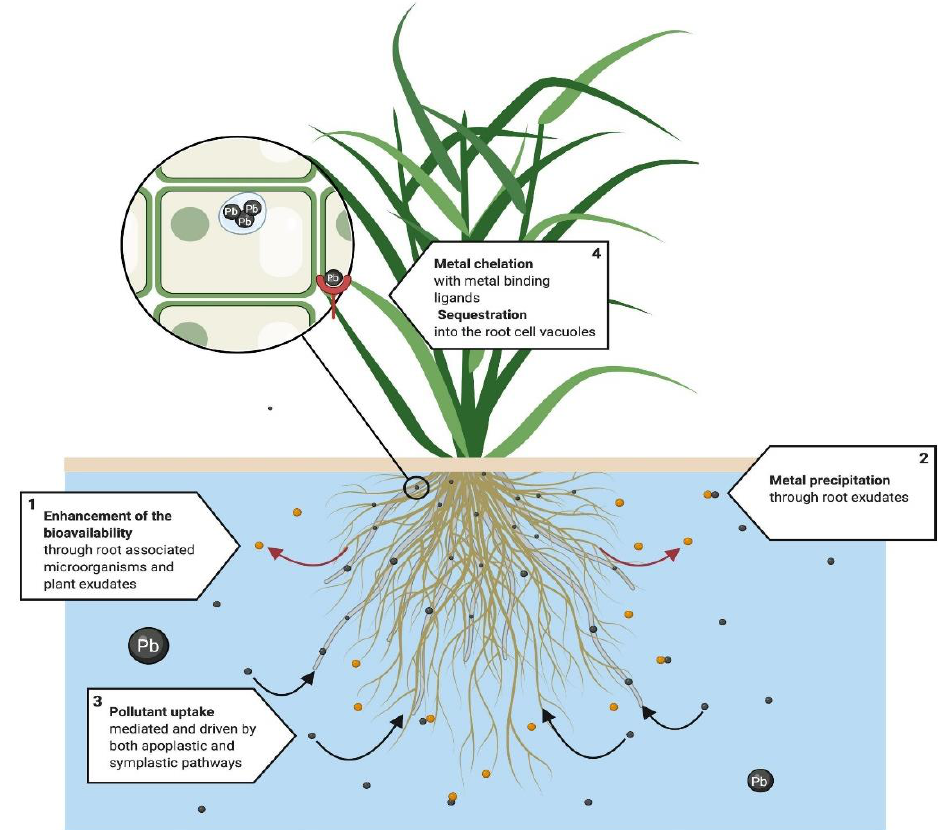
Figure 4. Proposed rhizofiltration system. This technique is mainly used in metal phytoremediation. From a physiological perspective, root exudates and microorganisms (1) enhance bioavailability, followed by (2) the precipitation of metals. (3) Pollutant uptake is mediated and driven by both apoplastic and symplastic pathways. If symplastic pathways fail to translocate the pollutant into leaves and steam, chelation and sequestration takes place mainly in the roots of the plant. (4) Metals are chelated by metal binding ligands, phytochelatins and metalloteines, and finally pollutants are either sequestered into the cell vacuoles and the apoplast or bound to the cell wall [114–117].